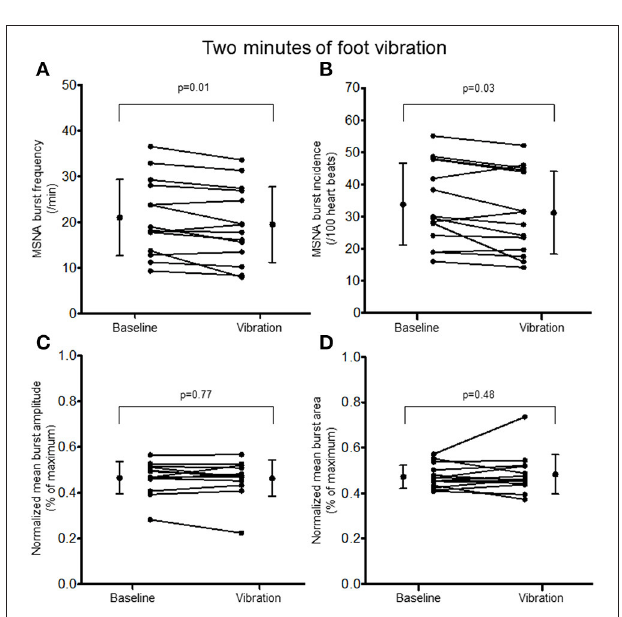
FIGURE 4 | Muscle sympathetic nerve activity (MSNA) burst frequency (A) , burst incidence (B) , and normalized mean burst amplitude (C) and area (D) during 2 min baseline rest and foot sole